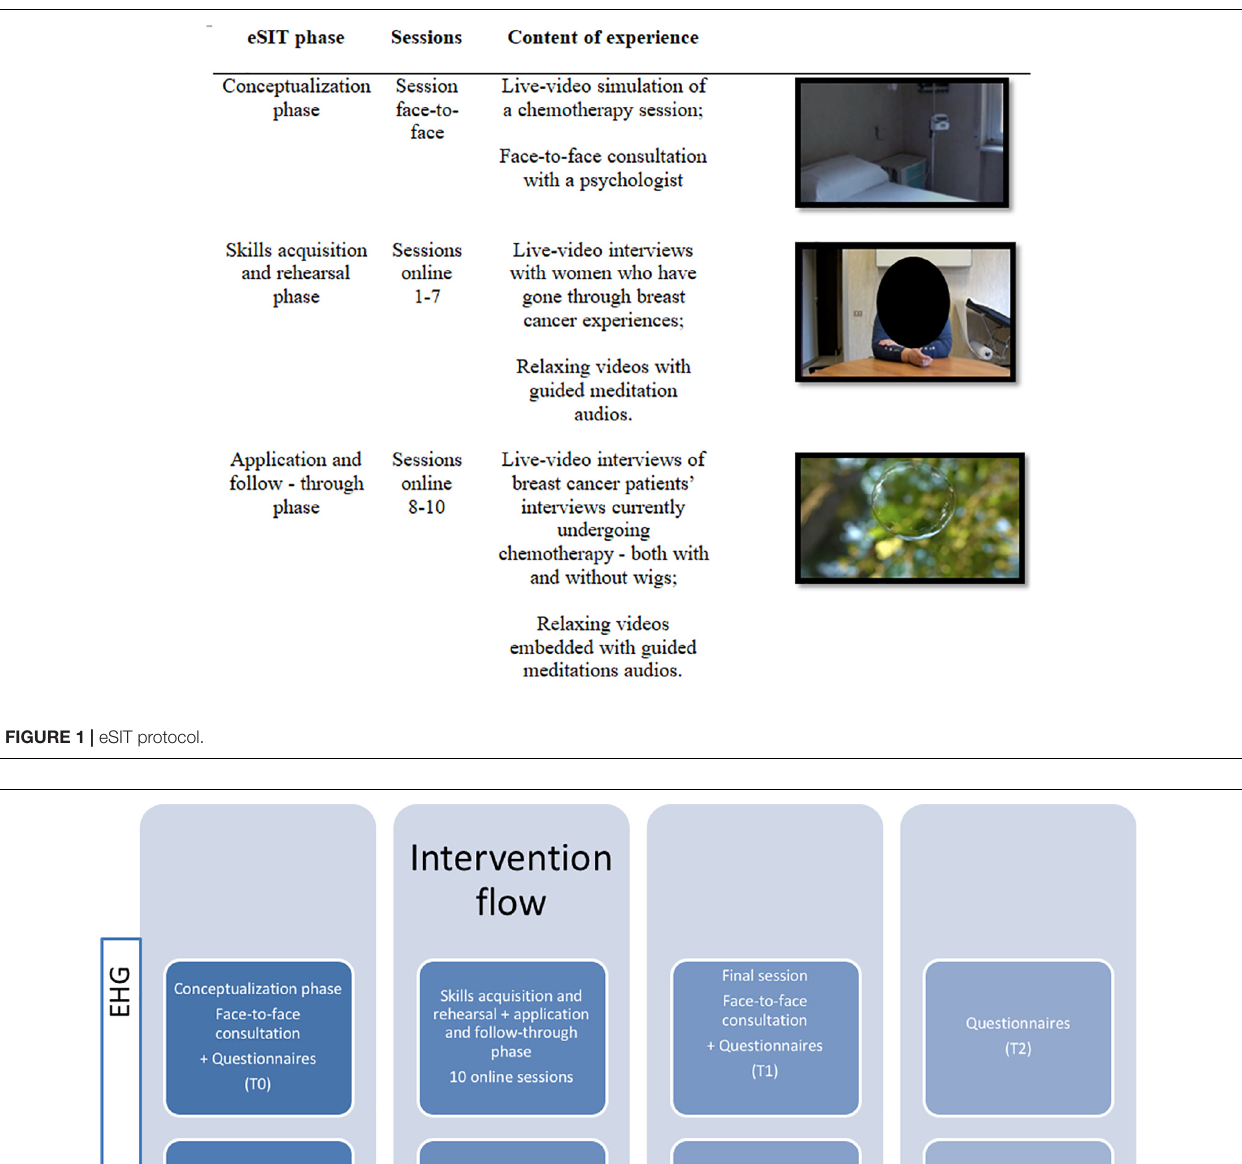
FIGURE 2 | Intervention